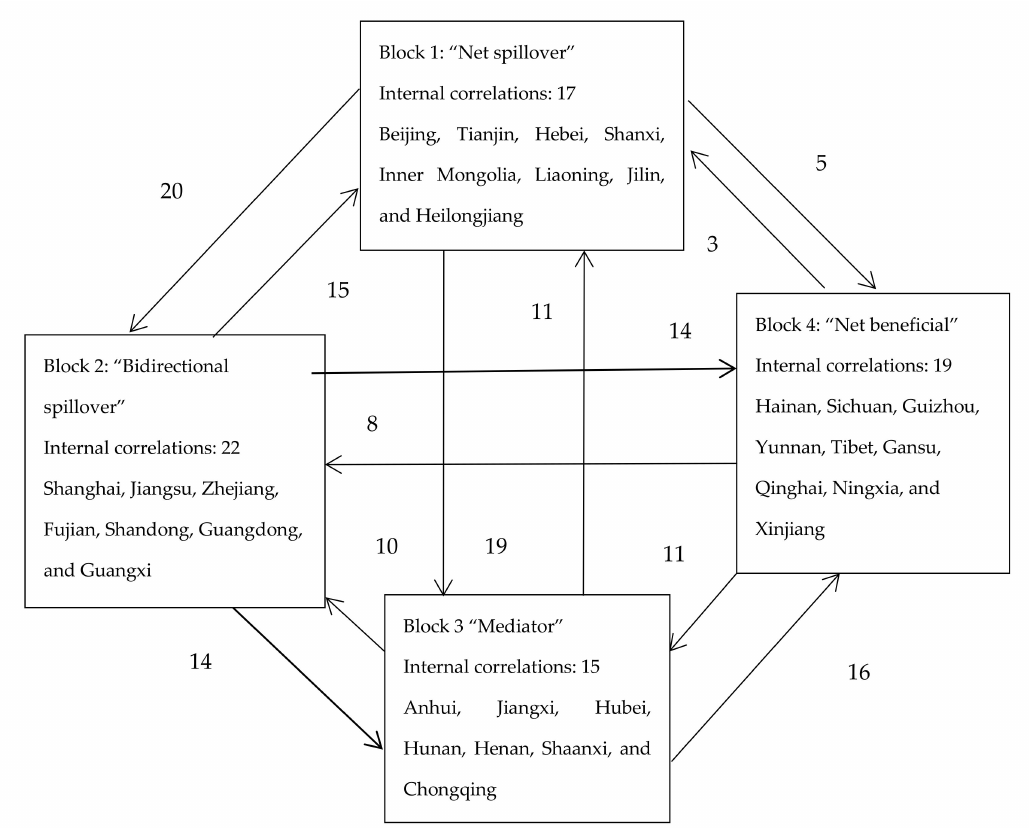
Figure 8. Correlations between the blocks of the spatial network of health resource aggregation capacities in China in